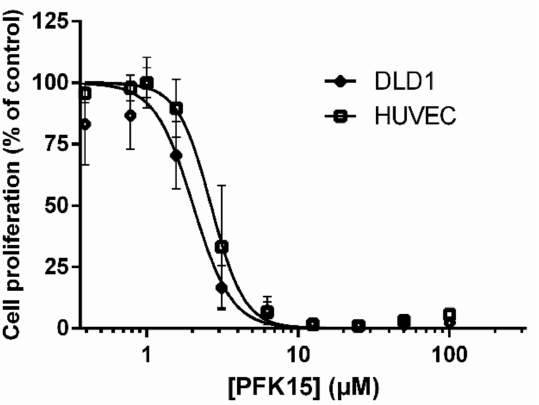
Figure 1. Dose-dependent effect of PFK15 treatment for 3 days on the proliferation of DLD1 and HUVEC cells. Cells were incubated with PFK15 in a concentration range from 0.39 to 100 µ M for 3 days. Data are expressed as the percentage of proliferation of PFK15-treated cells compared to untreated cells. Each point represents the mean of quadruplicate experiments. IC 50 values were calculated from a dose–response curve as the concentration of PFK15 yielding 50% of control cell survival.